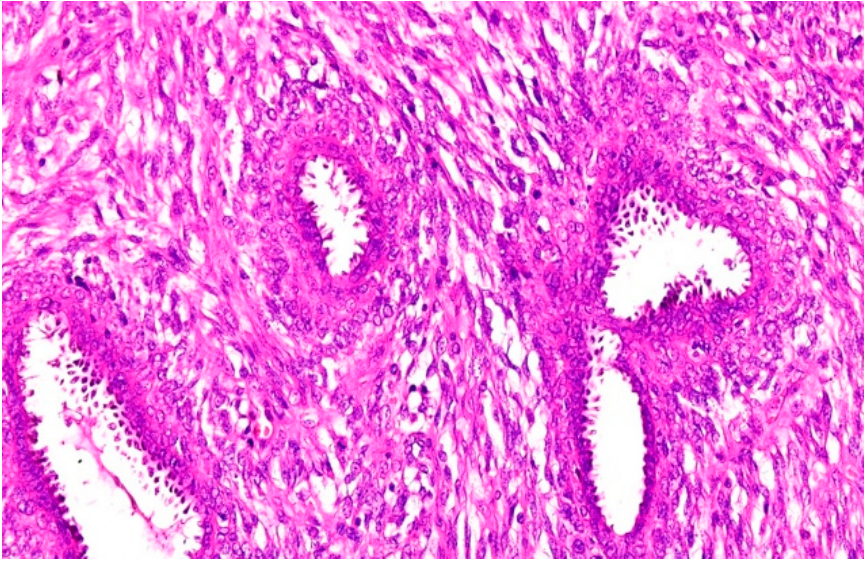
Figure 6. Borderline phyllodes tumor with moderate stromal cell atypia and stromal cell mitosis (H&E staining).